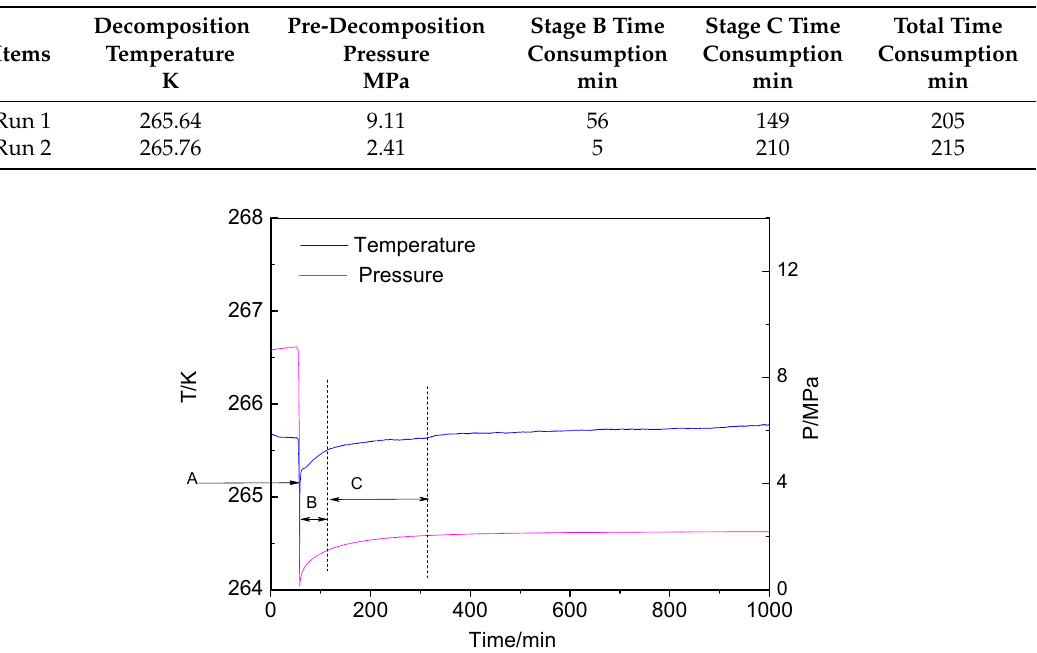
Figure 8. Decomposition from high pre-decomposition pressure. Table 3. Description of decompositions.